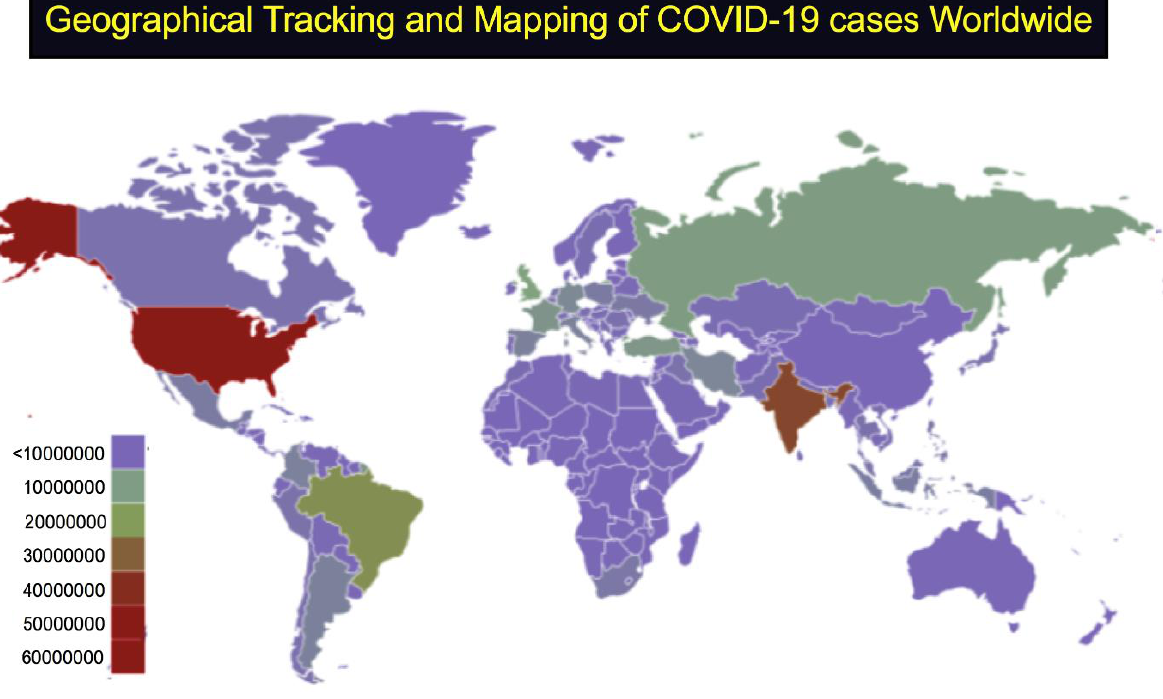
Figure 1. Geographical tracking and mapping of COVID-19 cases globally as of 13 September 2021. (Data Source: Worldometer, Figure redrawn using GeoMaps).